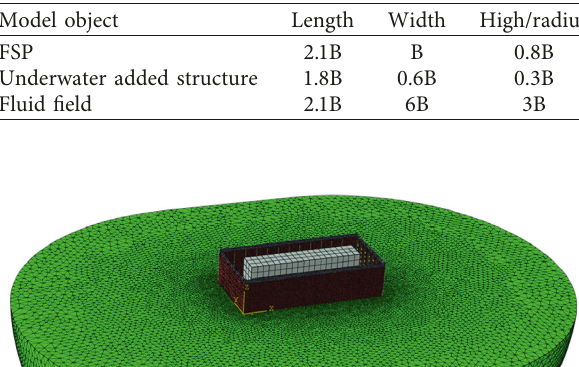
Table 2: The principal dimensions of the model.